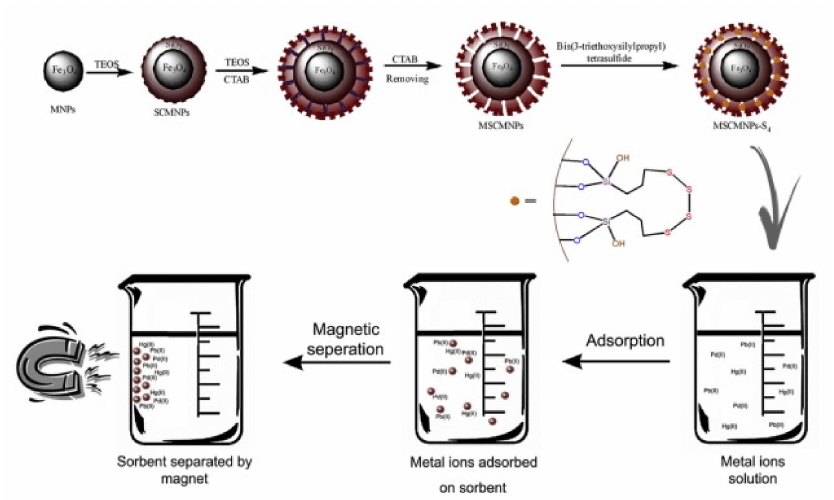
Figure 6. Schematic showing the mechanism of the magnetic nanoparticles in the removal of heavy metals. Reproduced with permission from [95].